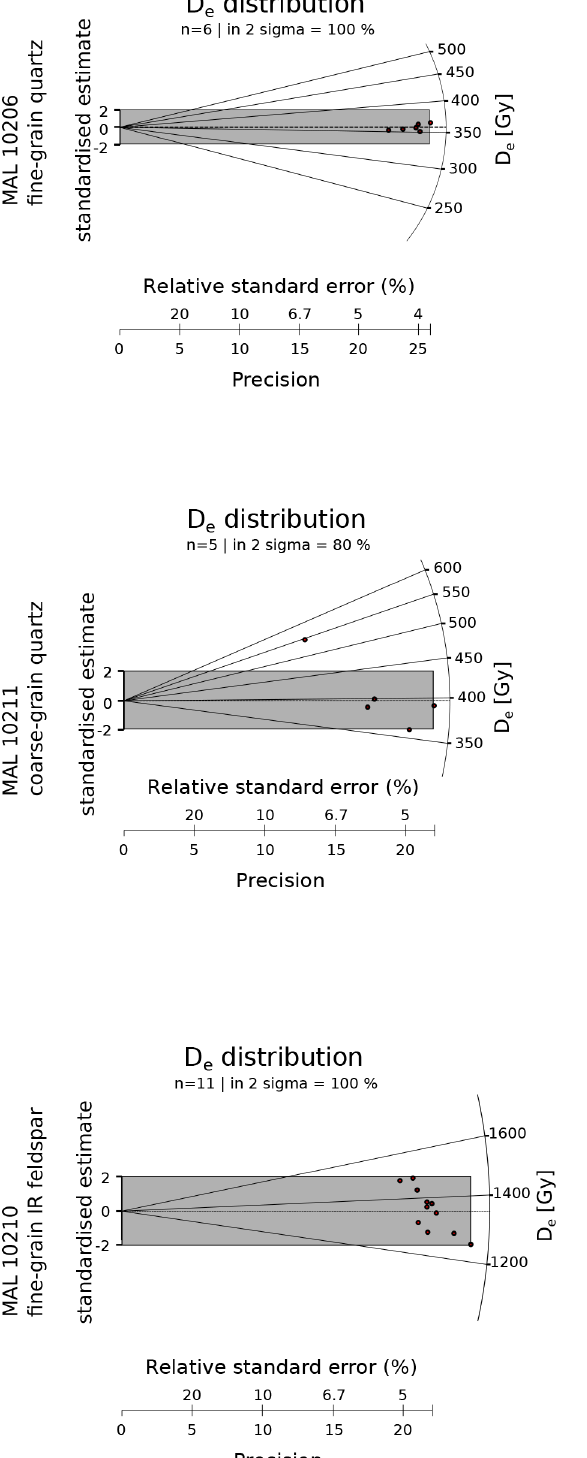
Figure A3. Sample radial plots for OSL and IRSL